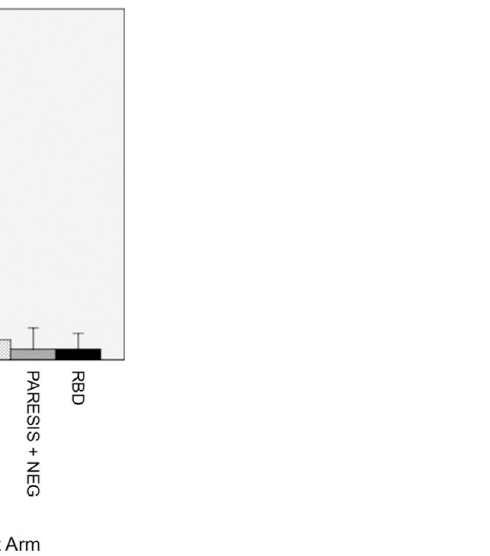
Fig 6. Experiment 3 (arm length estimate (to grasp) − implicit approach): Mean accuracy ratios of nineteen patients from the four subject groups measured in the chronic phase of the stroke as well as the mean accuracy ratio from healthy controls. Bars represent standard deviations. Healthy, PARESIS, PARESIS+NEG, RBD as in Fig 3.